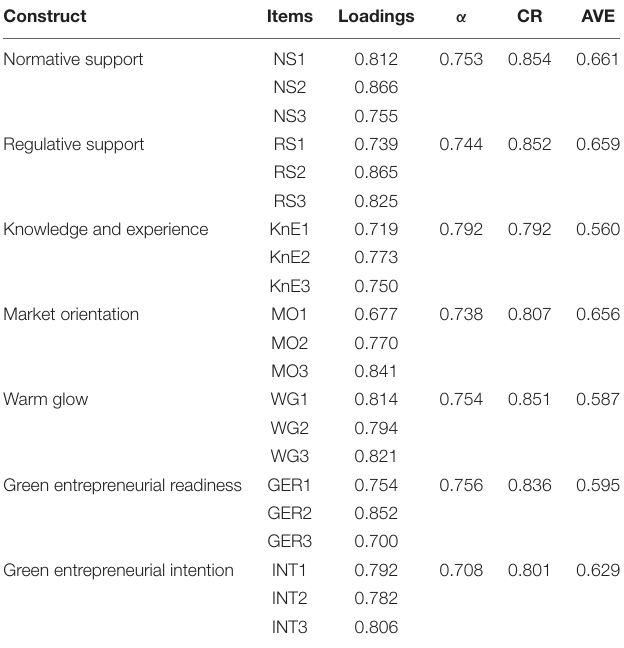
TABLE 3 | Exploring reliability and validity analysis.